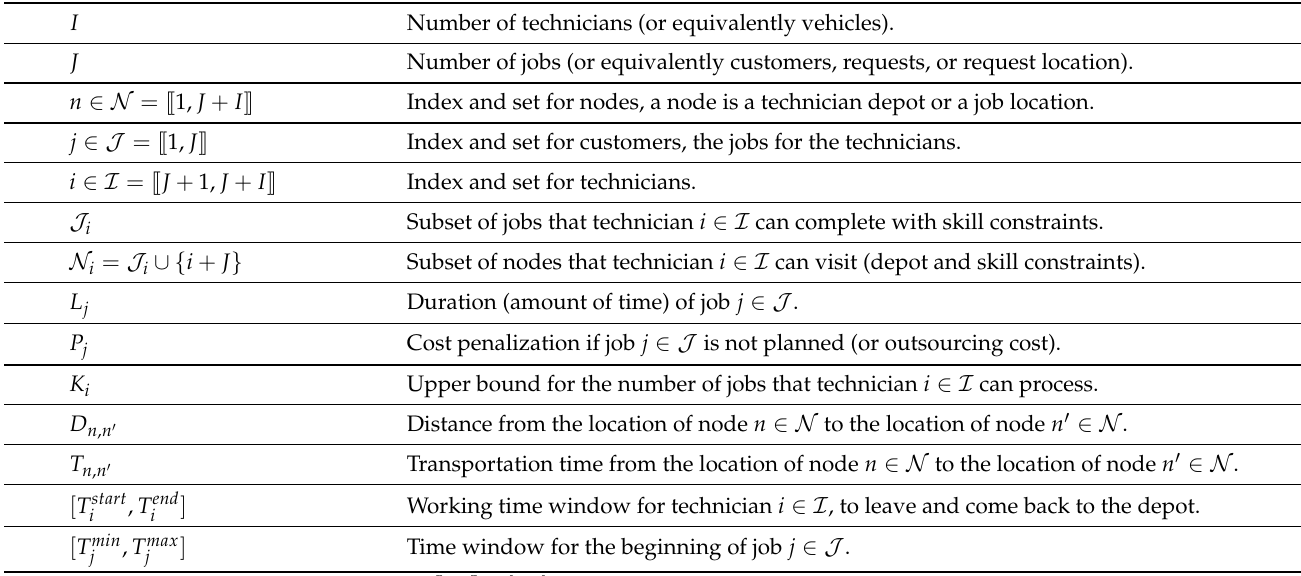
Table 1. Notation, sets, indexes and input